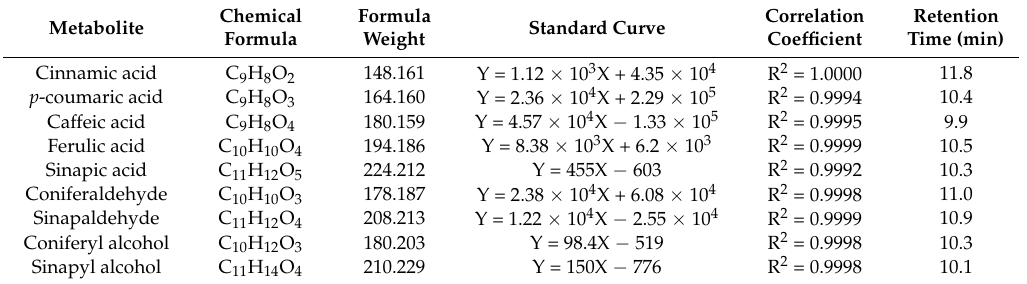
Correlation Retention Coefficient Time (min)